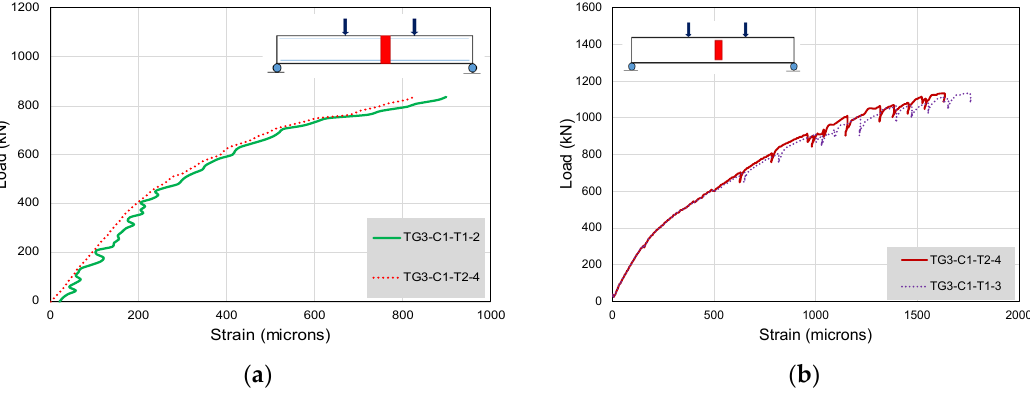
Figure 43. Load versus strain responses at location C1 ( a ) load SP-3-L01 ( b ) load SP-3-L02.